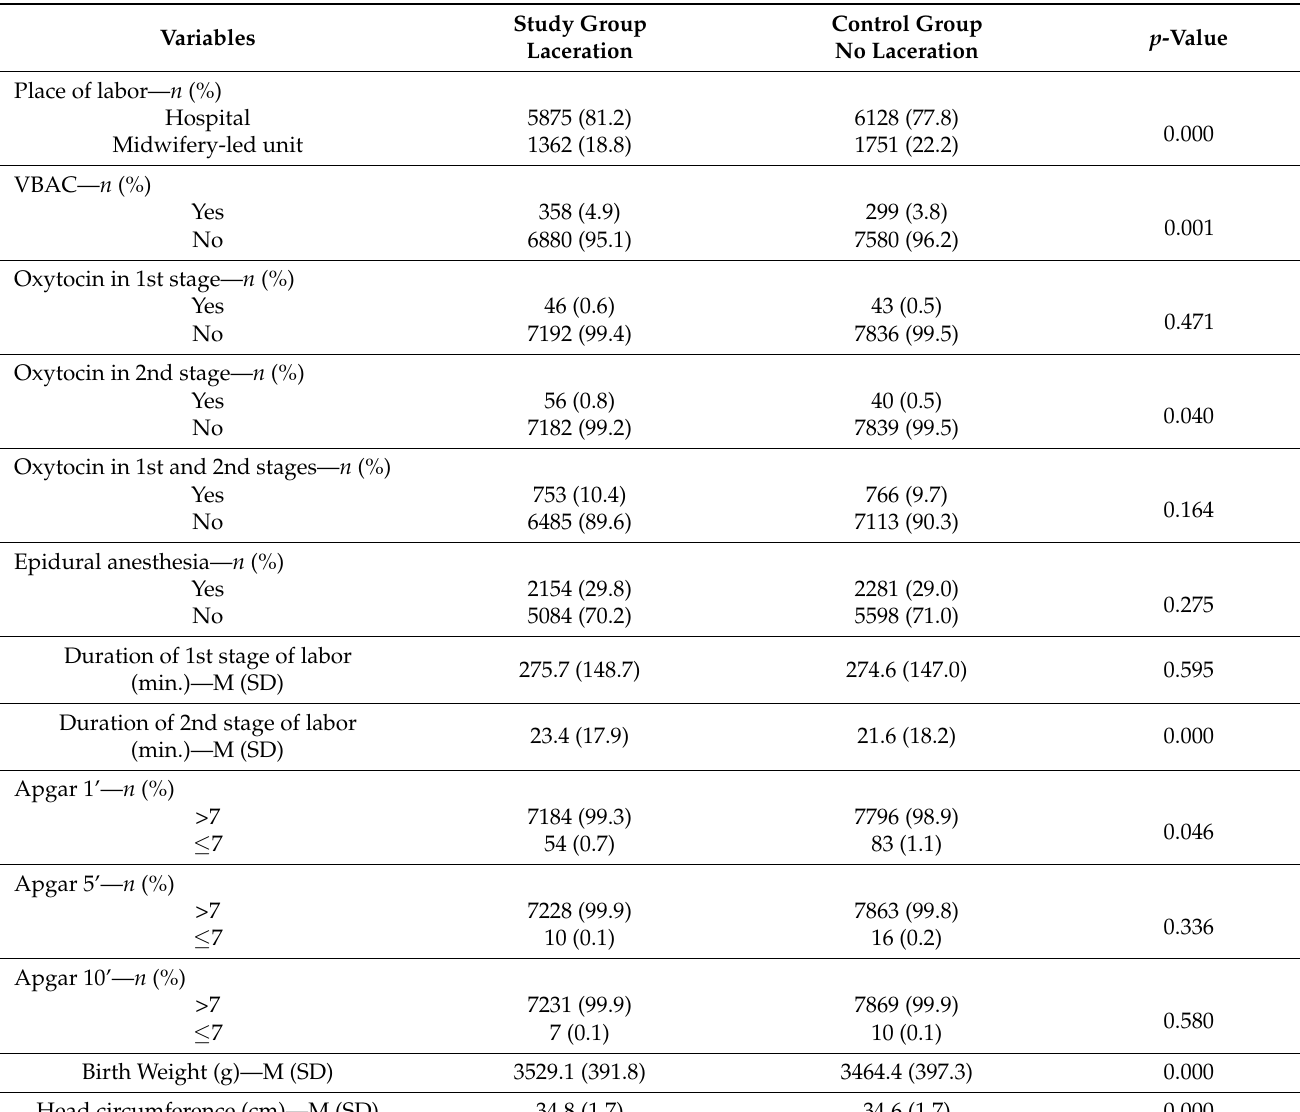
Table 2. Analysis of the dependencies between the occurrence of perineal laceration and perinatal and neonatal